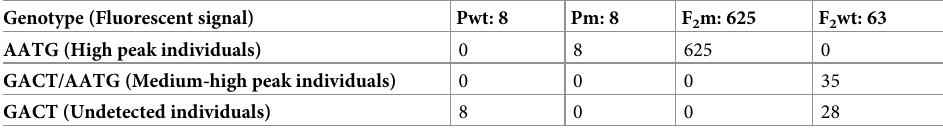
Table 1. Taqman probe detection of linkage between SNP mutations and the mutant phenotype. Genotype (Fluorescent signal) Pwt: 8 Pm: 8 F 2 m: 625 F 2 wt: 63 AATG (High peak individuals) 0 8 625 0 GACT/AATG (Medium-high peak individuals) 0 0 0 35 GACT (Undetected individuals) 8 0 0 28 Pwt means parent individuals with wild-type character, Pm indicates parent individuals with mutant phenotype, F 2 m indicates number of individuals with mutant phenotype in F 2 population, F 2 wt indicates individual number of F 2 population with wild-type